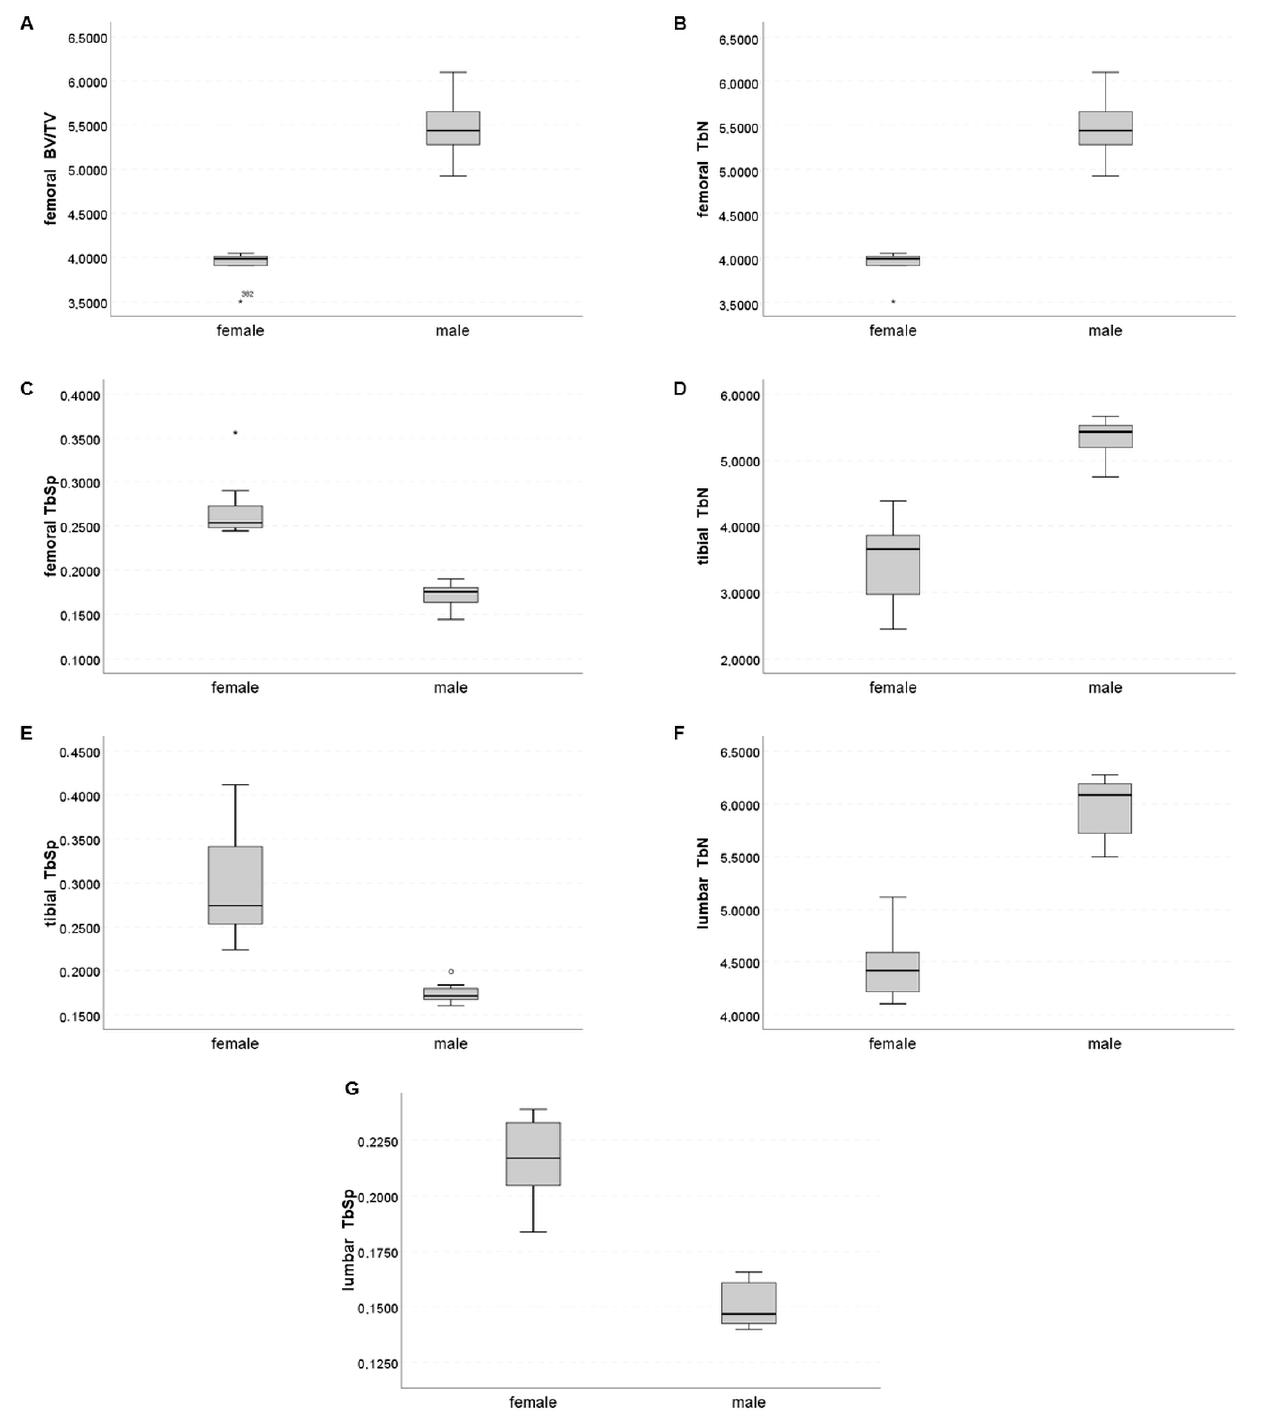
Figure 2. Boxplots of ( A ) femoral BV/TV, ( B ) femoral TbN, ( C ) femoral TbSp, ( D ) tibial TbN, ( E ) tibial TbSp, ( F ) lumbar TbN, and ( G ) lumbar TbSp. *, ° indicate outliers.